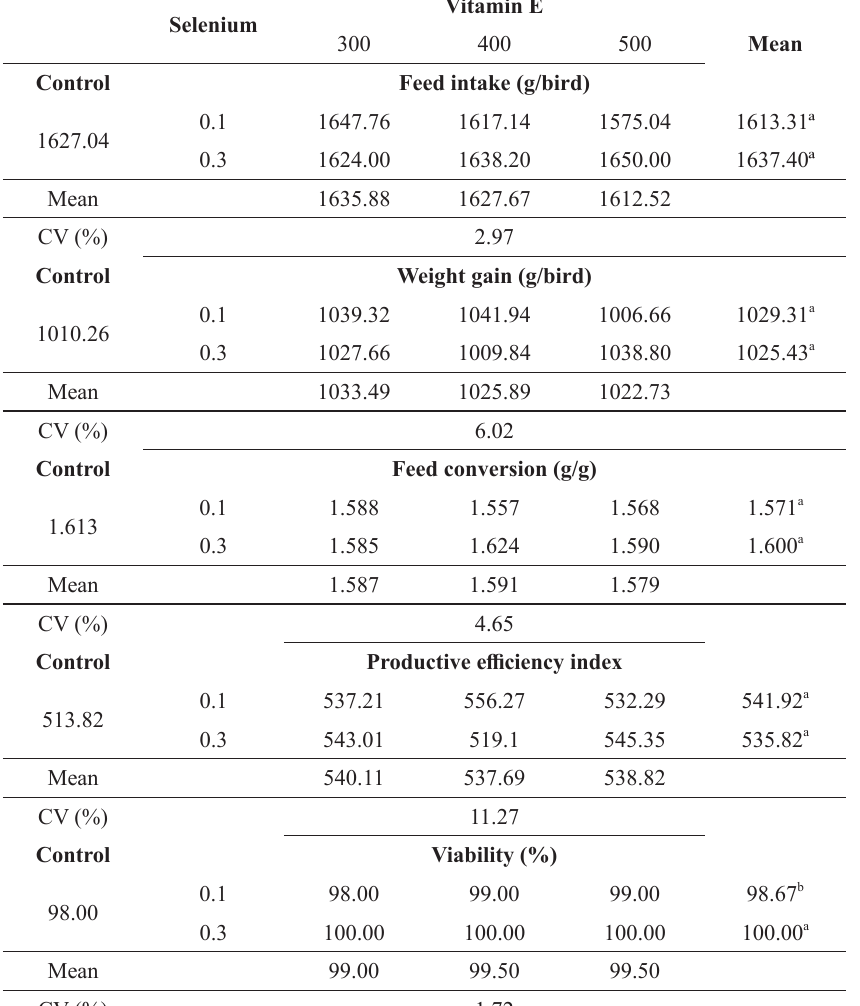
Performance of broilers from 22 to 33 days old fed different levels of selenium and vitamin E.